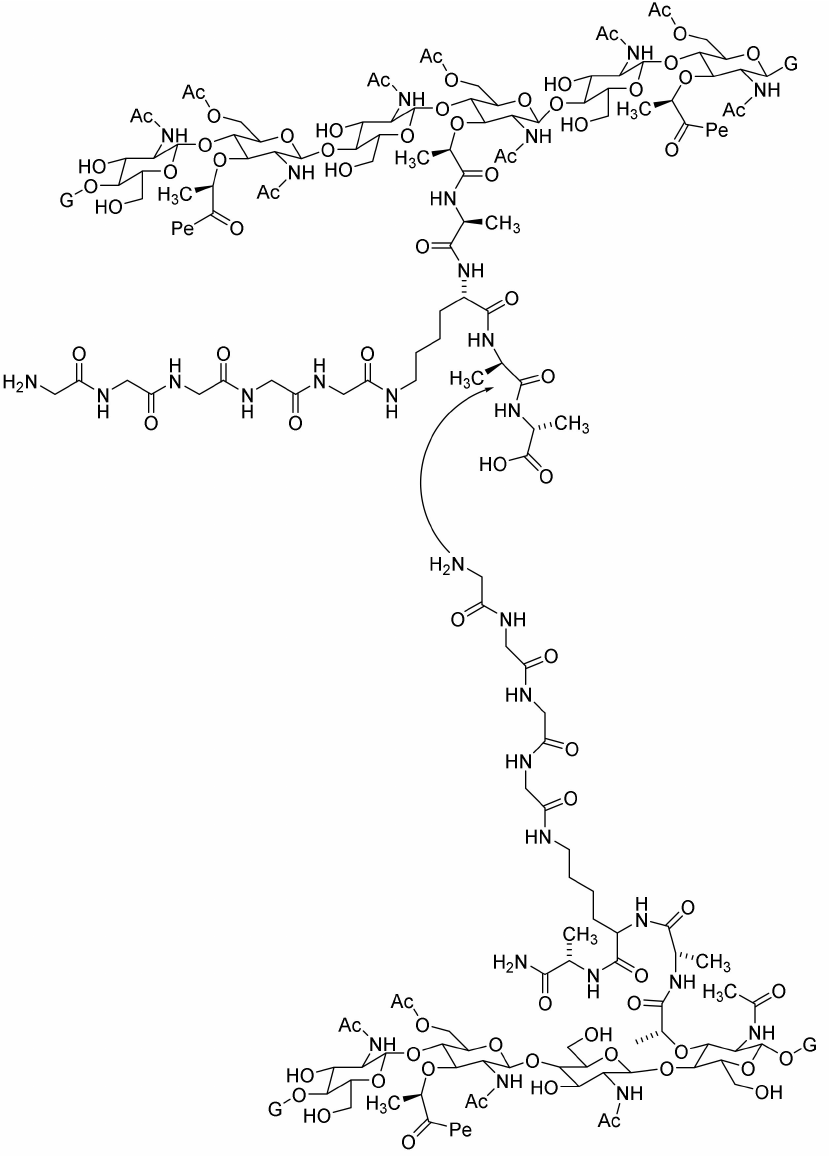
Figure 8. Mechanism for cross binding [44,58]. Pe indicates the attachment of an additional cross binding peptide by a peptide bond to N -acetymuramic acid. G indicates prolongation with other units of the dimer N -acetylglucosamine- N -acetylmuramic